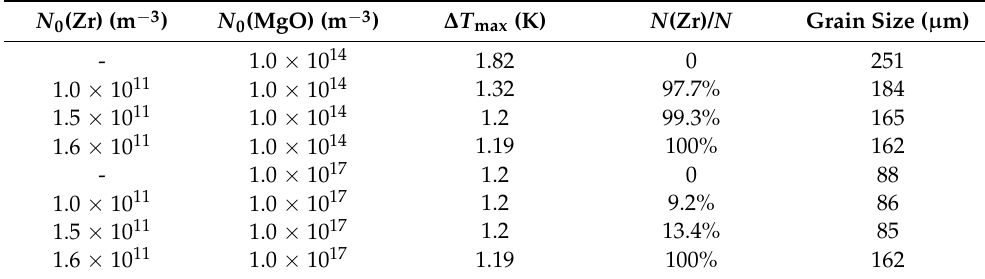
Table 2. The calculated results of Mg-Zr alloys (the Zr content is slightly higher than C m 0.45 wt.%) without and with intensive melt shearing prior to the addition of Zr particles. N 0 (MgO) = 1.0 × 10 14 for non-sheared melt and N 0 (MgO) = 1.0 × 10 17 m − 3 for sheared melt. N 0 (Zr) (m − 3